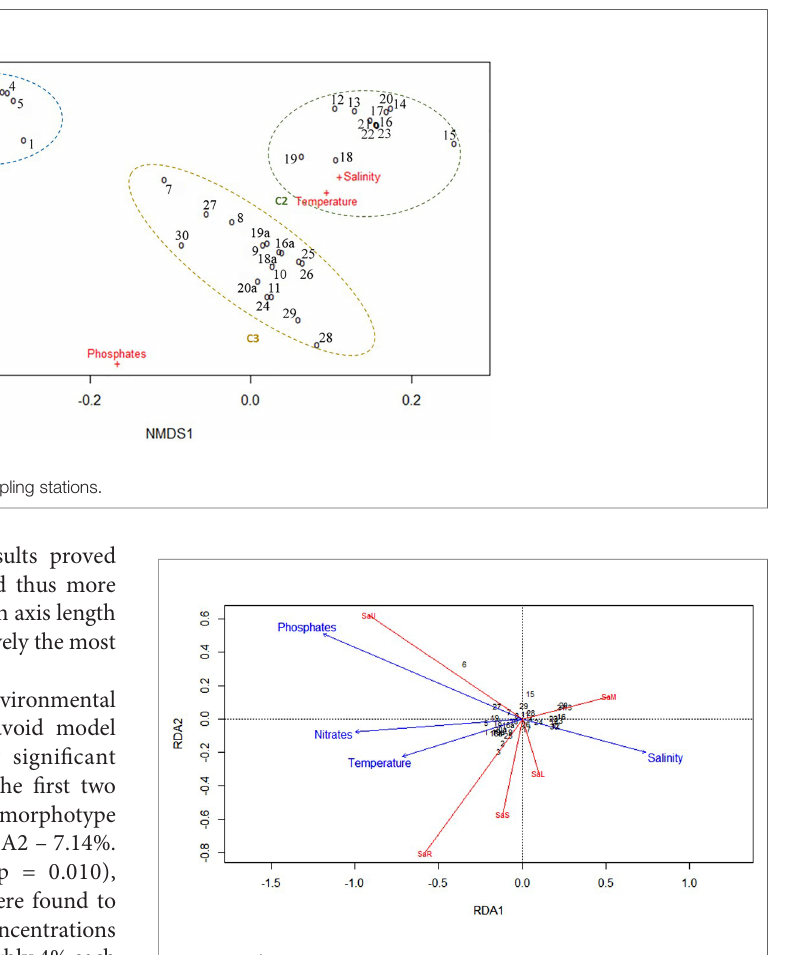
FIGURE 6 | RDA Correlation Triplot (scaling type 2 – lc) between environmental multiyear explanatory dataset and the corresponding response cysts matrix with fi tted site